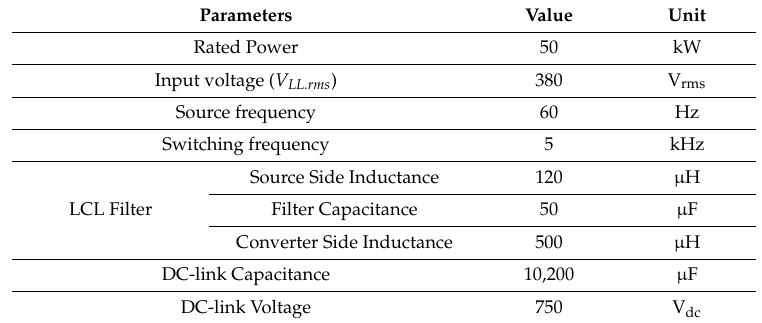
Table 1. Parameter of proposed AC/DC pulse width modulation (PWM) converter.